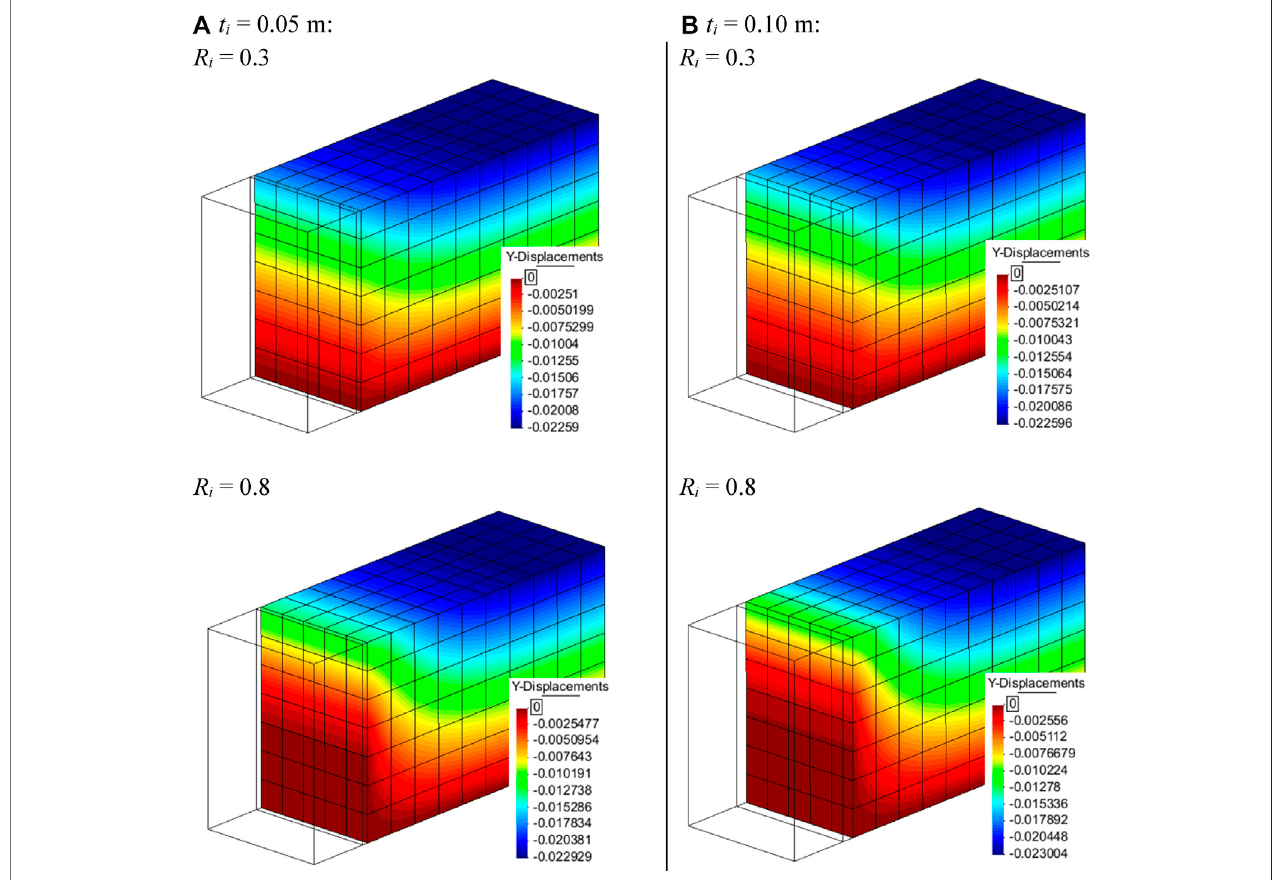
FIGURE 18 | Settlement results (units in meters) under q = 100-kPa surcharge located at top of the soil zone and interface thickness (A) ti = 0.05 m and (B) ti = 0.10 m.